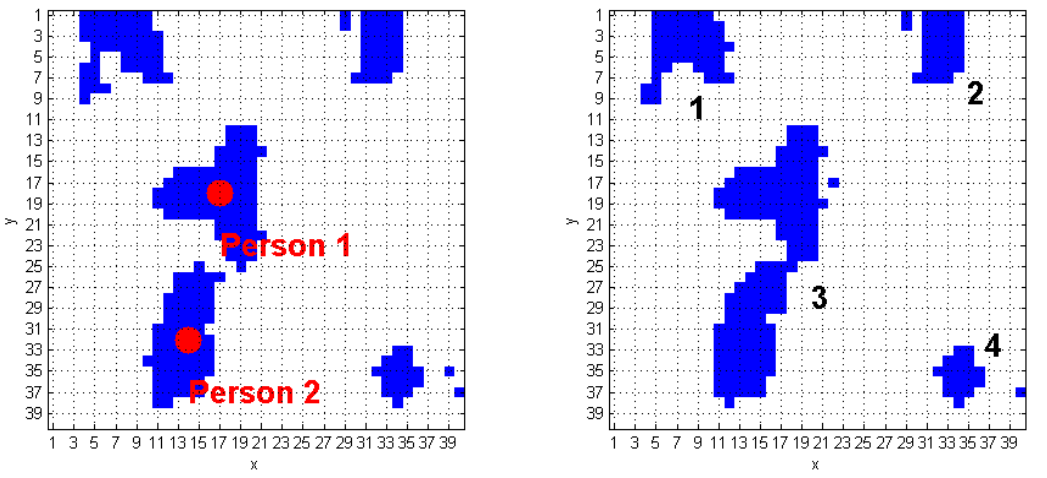
Table 2. TrackingInfo data structure referred to the k-th FF frame of Figure 7. Blob